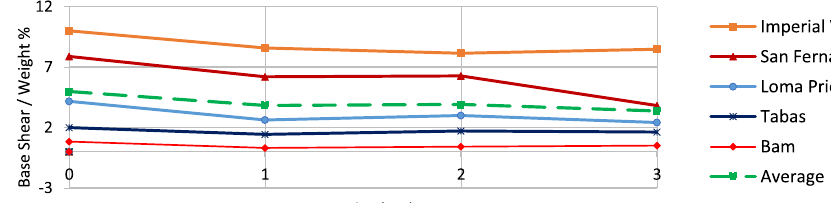
Fig. 9 Base shear/weight for different earthquakes